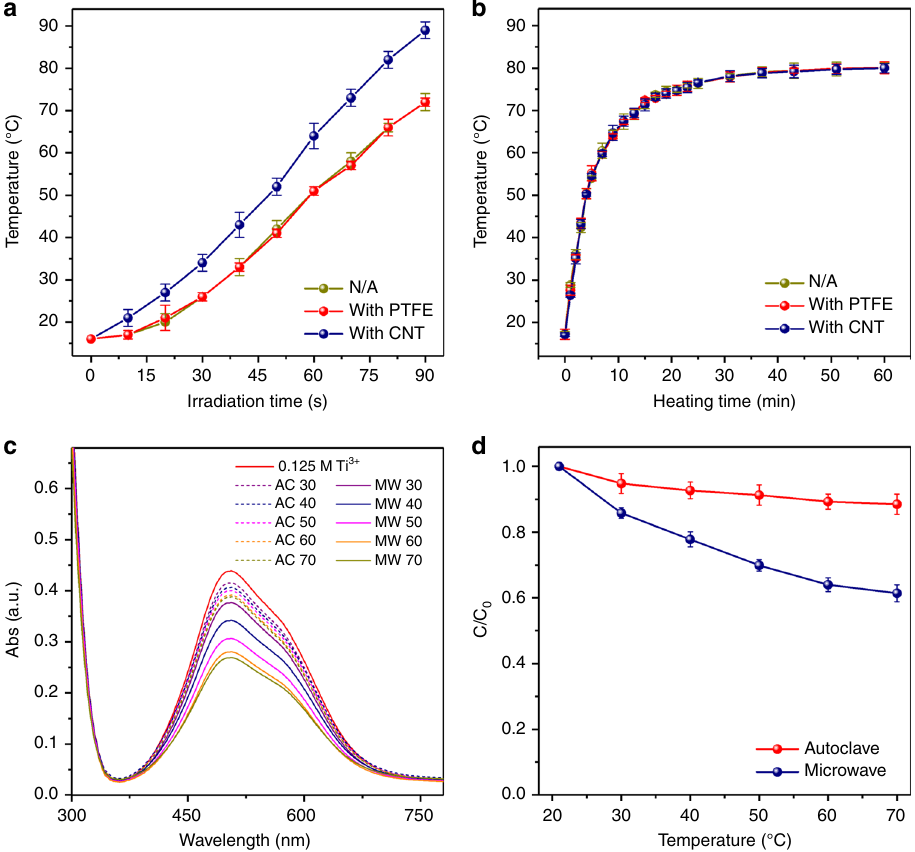
Fig. 4 Microwave effects on CNTs. Plots of the temperature of DMSO solution (200 mL) vs. heating time in the presence or absence of CNTs and PTFE (100 mg) with the heating source of ( a ) microwave irradiation (800 W) and ( b ) oil bath (90 °C). The Ti 3 + adsorption properties of CNTs: ( c ) UV-Vis spectra of TiCl 3 solution and ( d ) temperature-dependent concentration change of Ti 3 + under microwave irradiation and autoclave hydrothermal heating by keeping the speci fi c temperature for 20